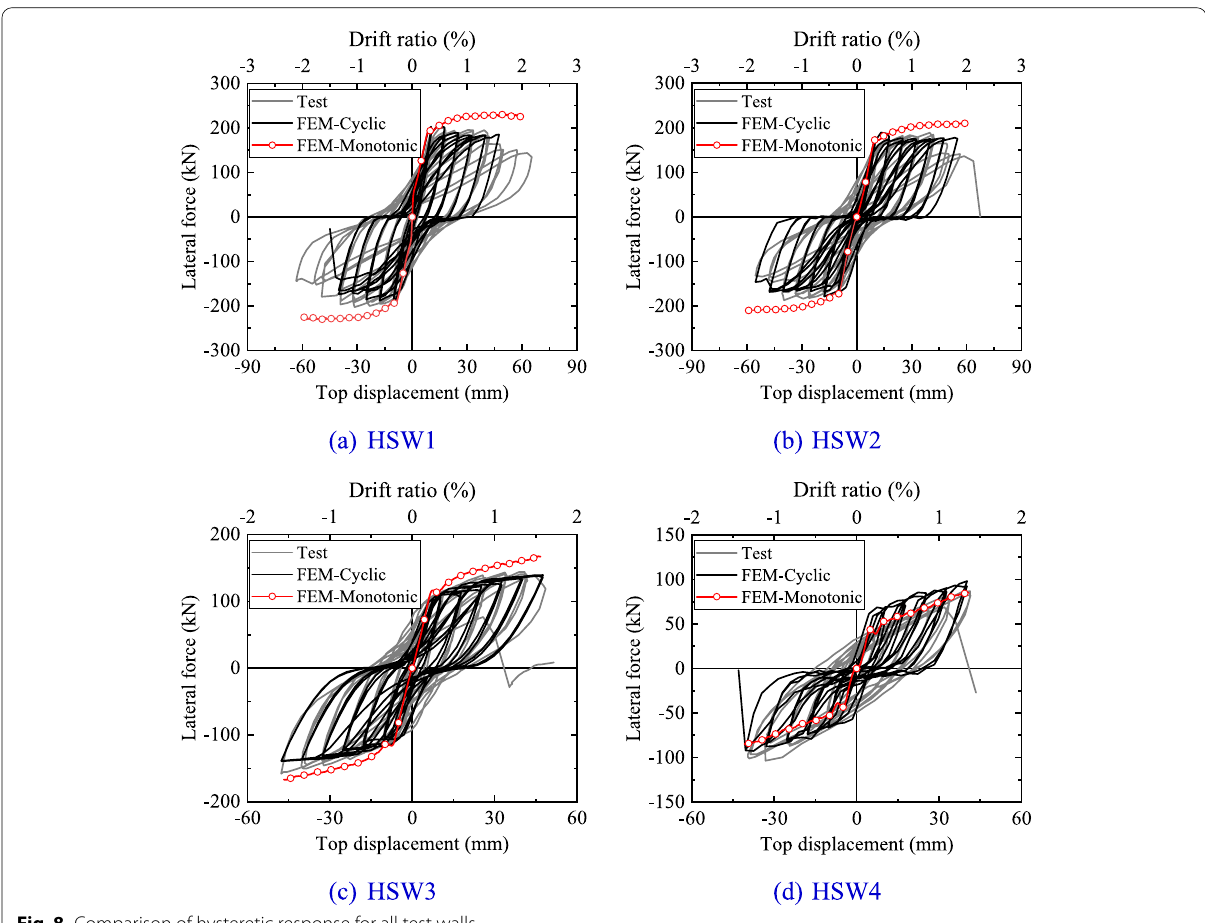
Fig. 8 Comparison of hysteretic response for all test